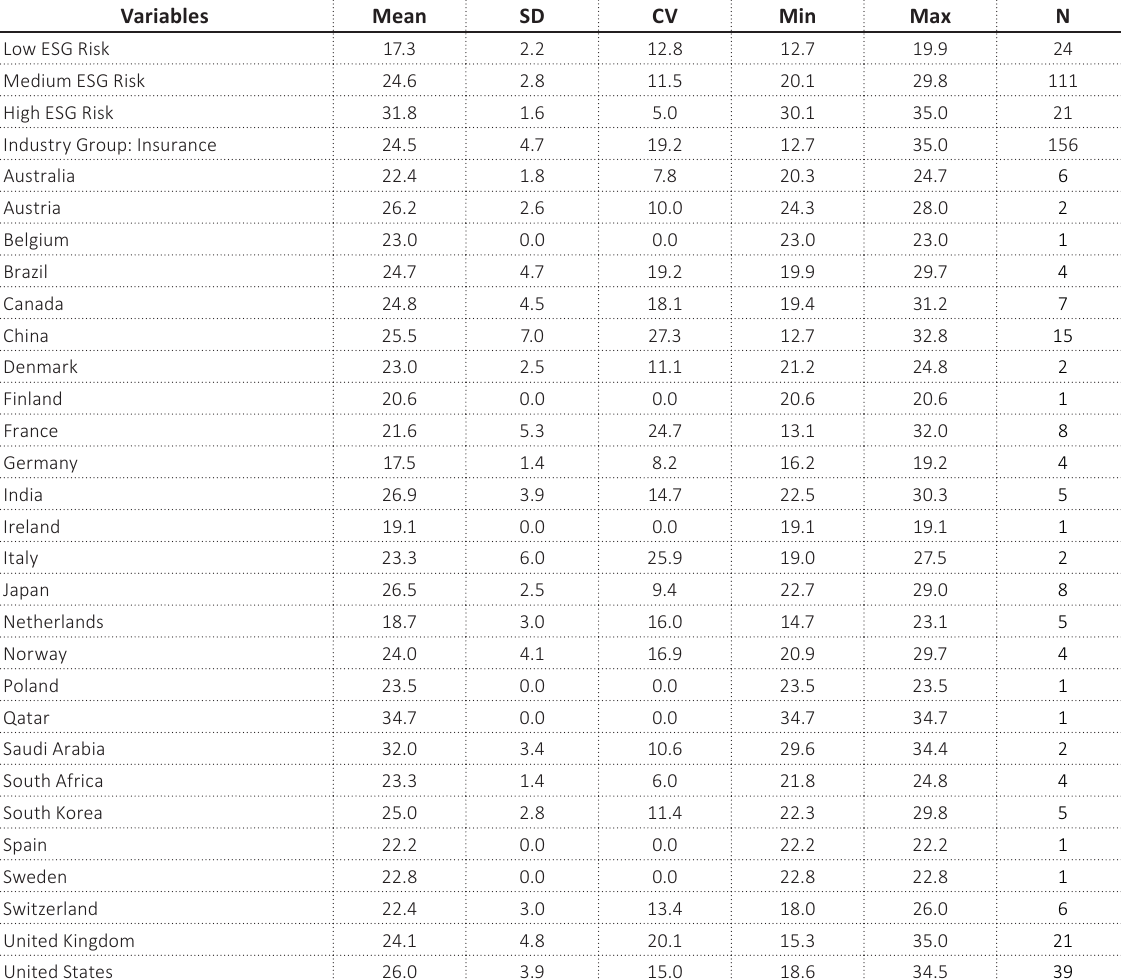
Table 2. Descriptive statistics for Company ESG Risk Ratings, 2020 Source: Calculated by the author based on the data from the Sustainalytics